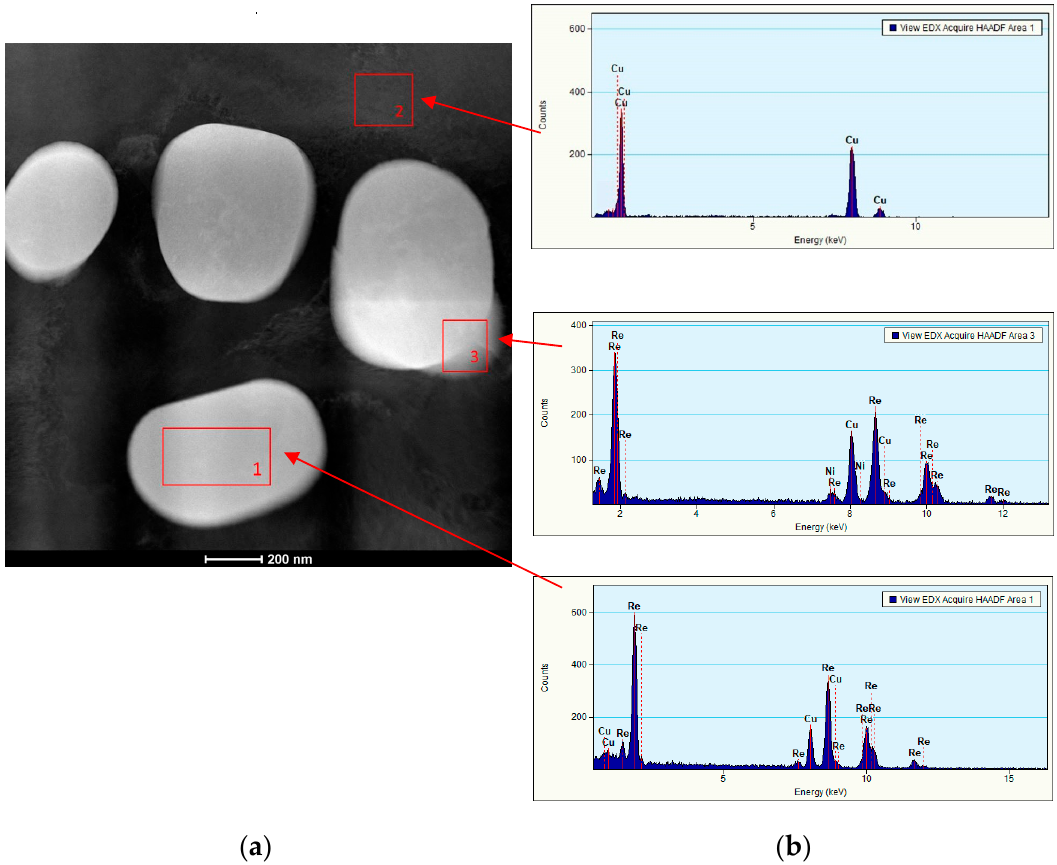
Figure 10. Structure of Cu–2Ni–1Si alloy modified with Re after heat treatment and cold plastic deformation ( a ), analysis of 1, 2 and 3 zones made with energy-dispersive X-ray spectroscopy ( b ).